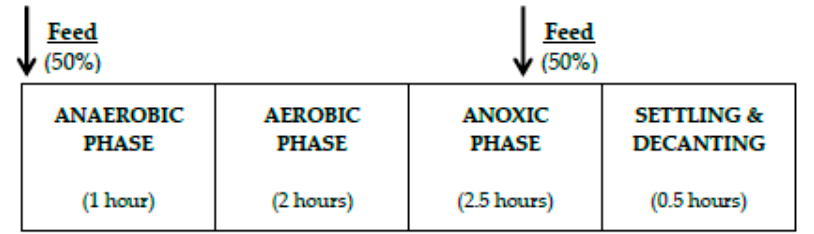
Figure 1. The schematic illustration of the sequencing batch reactor (SBR) operation cycle.